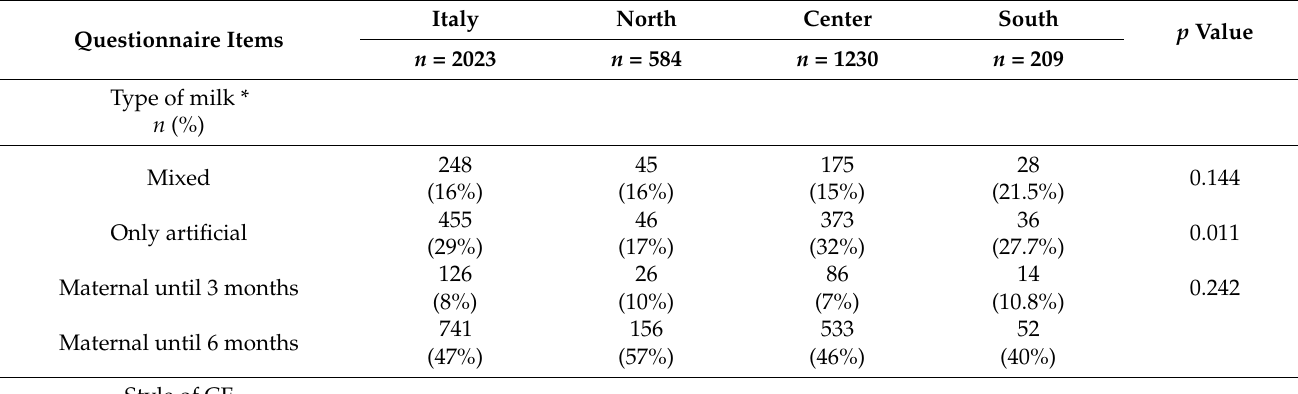
Table 4. Data collected from families and differences based on the area of